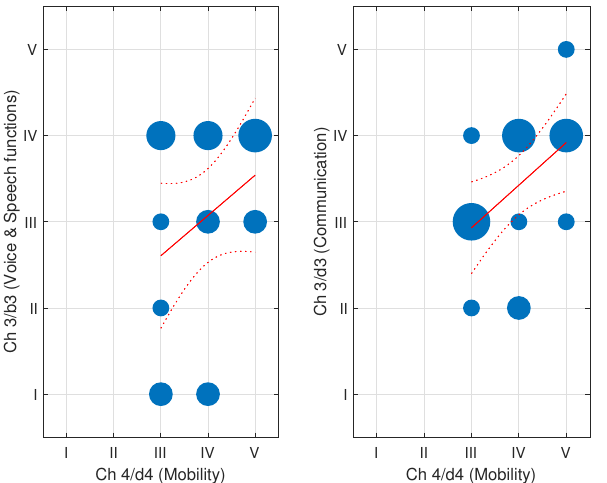
Figure 2. On the ( left ), bubble chart comparing the ICF items Ch3/b3 (voice and speech functions) to Ch4/d4 (mobility) of the assessed population in ASPACE. On the ( right ), the bubble chart comparing Ch3/d3 (communication) to Ch4/d4 (mobility). The sizes of the blue circles are proportional to the number of occurrences. The linear regression (solid line) and the confidence intervals (dotted line) are also shown in